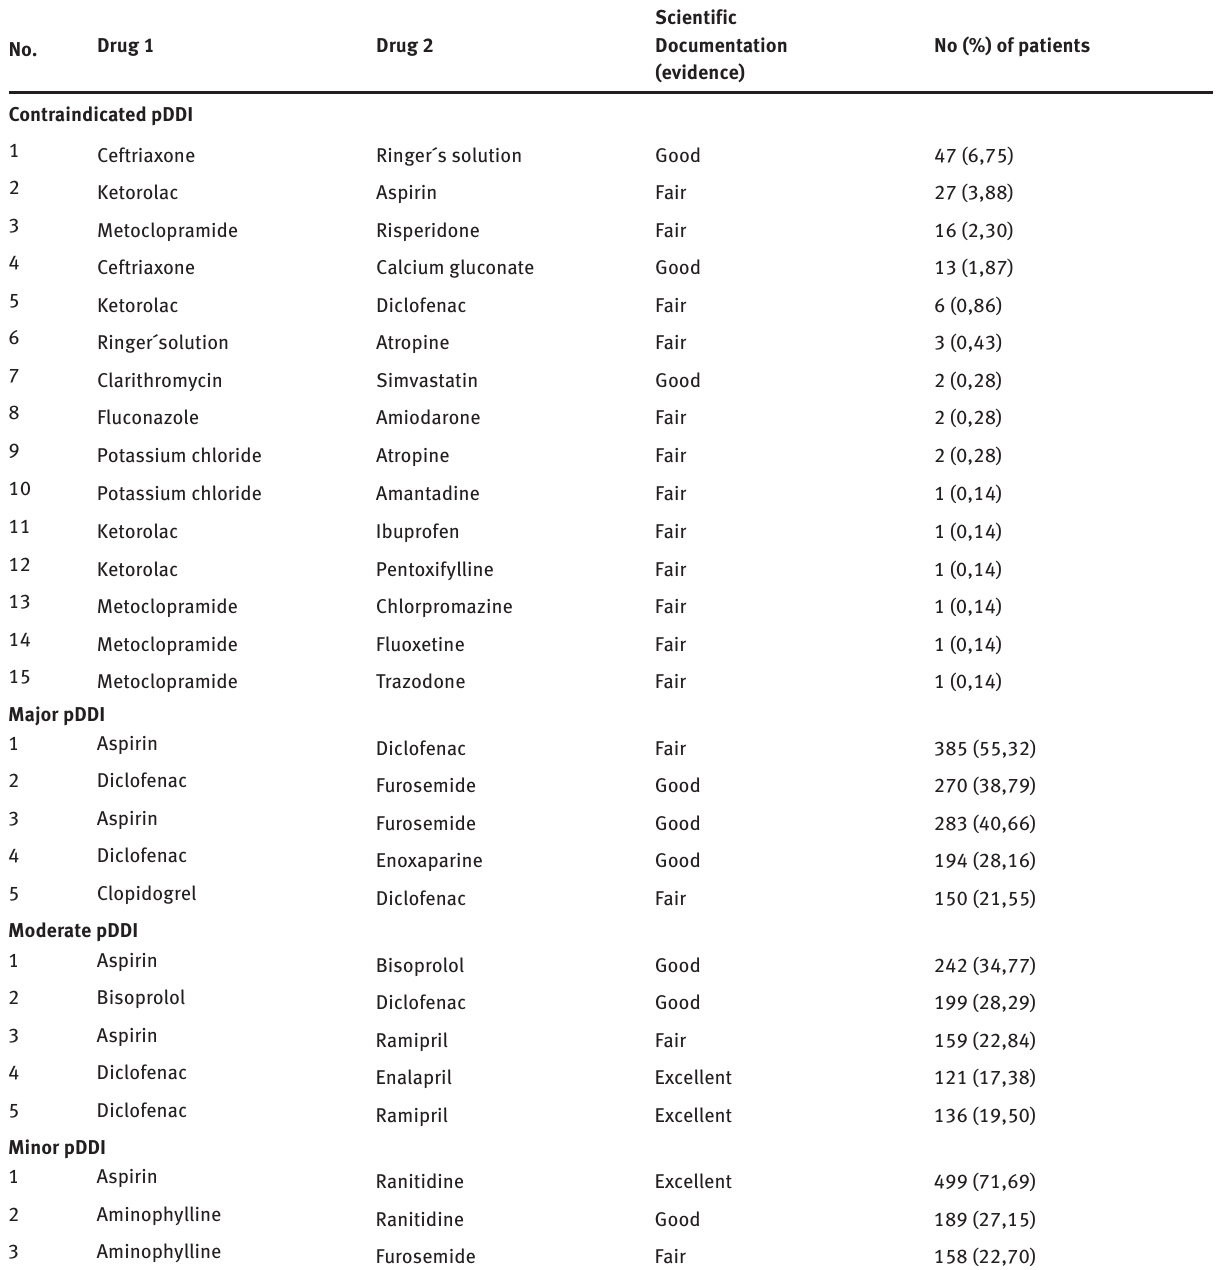
Table 3: All contraindicated potential drug-drug interactions pDDIs and the most frequent major, moderate and minor pDDIs.